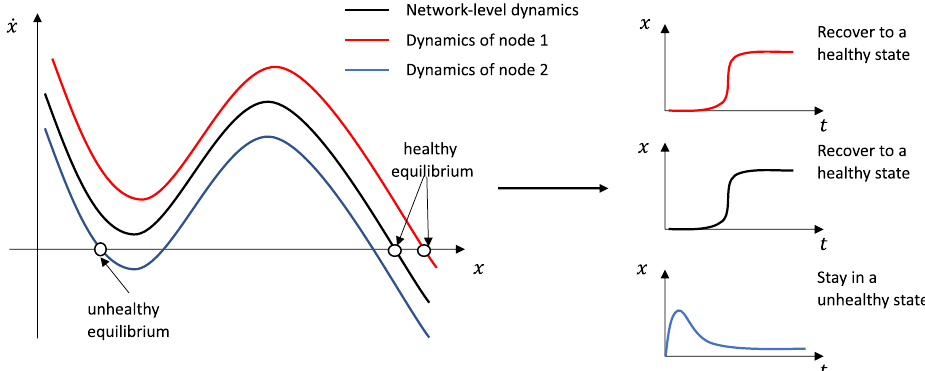
Figure 3. Similar network dynamics hide different node dynamics. It shows different dynamic response at node level. While the mean dynamics shows that the network is resilient, node 1 and node 2 have different dynamics. Node 1 only has one healthy equilibrium, but node 2 has a healthy equilibrium and an unhealthy equilibrium. Node 1 recovers to the healthy state, while node2 remains in an unhealthy state at last.